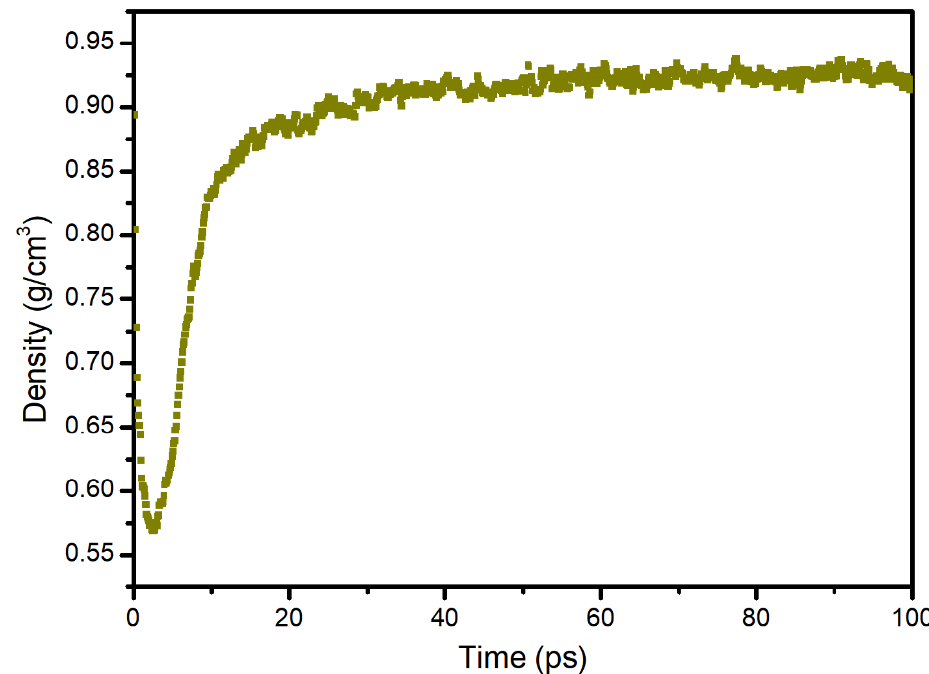
Figure 17. Change in the system density with time during the diffusion process of sunflower oil in the asphalt.